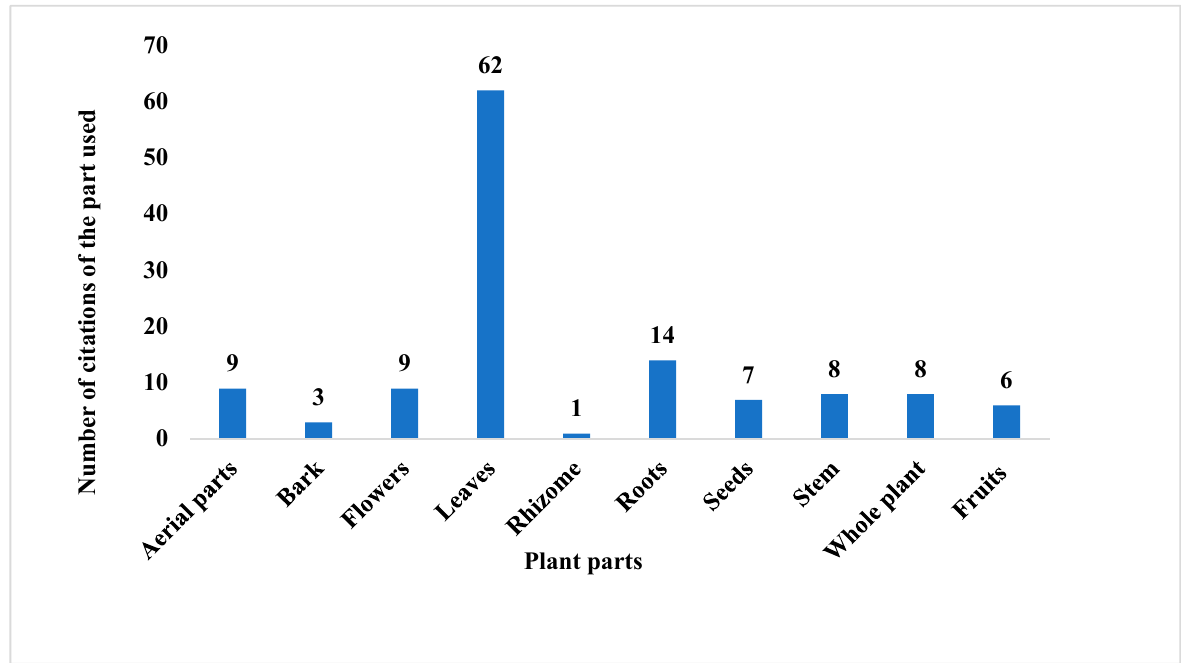
Figure 4. Representation of the number of citations of plant parts used.